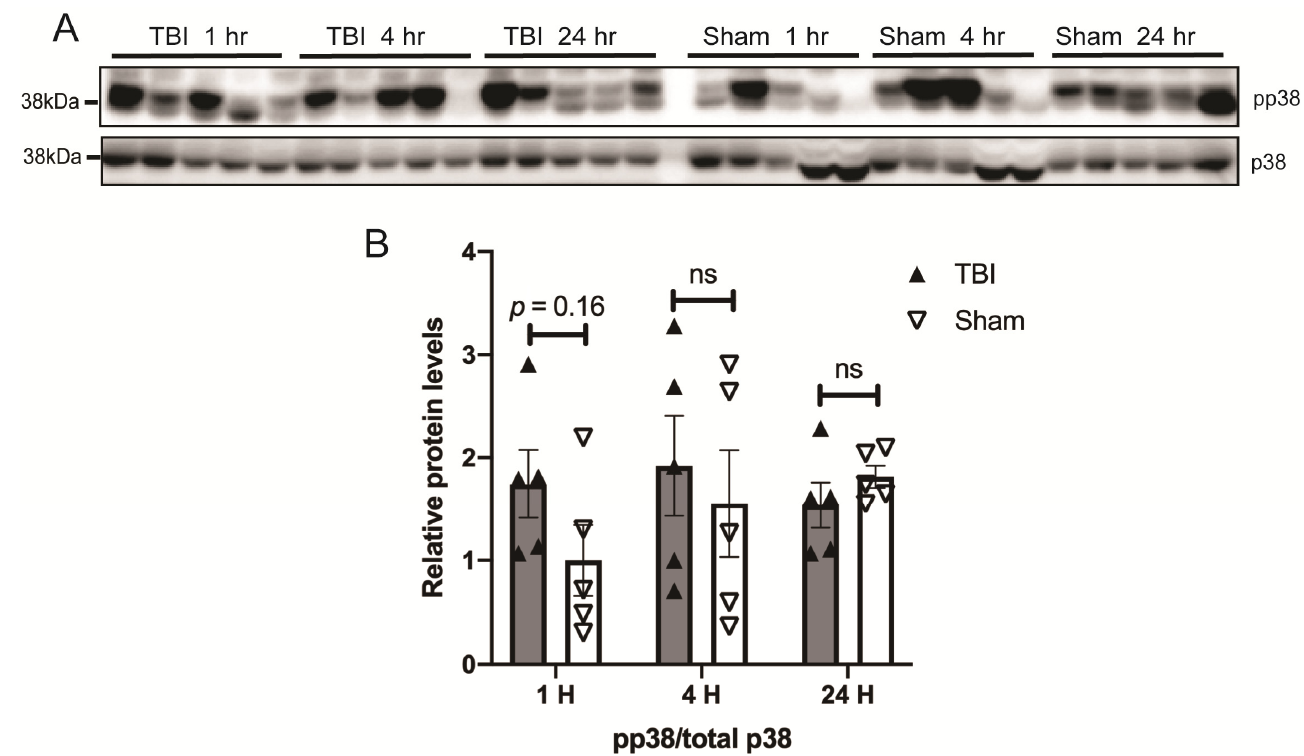
Figure 6. BOP caused a trend toward the activation of p38 in the mouse brain. Representative Western blots ( A ) and quantification analysis ( B ) revealed the activation of p38 after blast ( n = 5/group). (Data are means ± SEM; ns, non-significant).